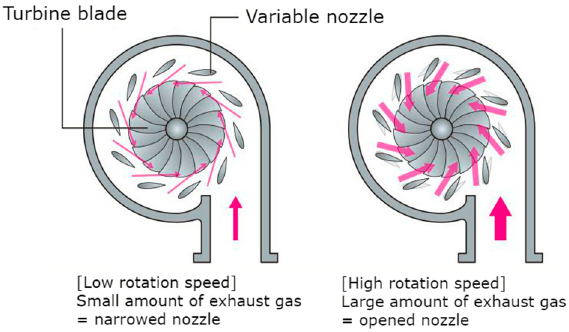
Figure 1. Variable geometry turbocharger (VGT) operating principle.